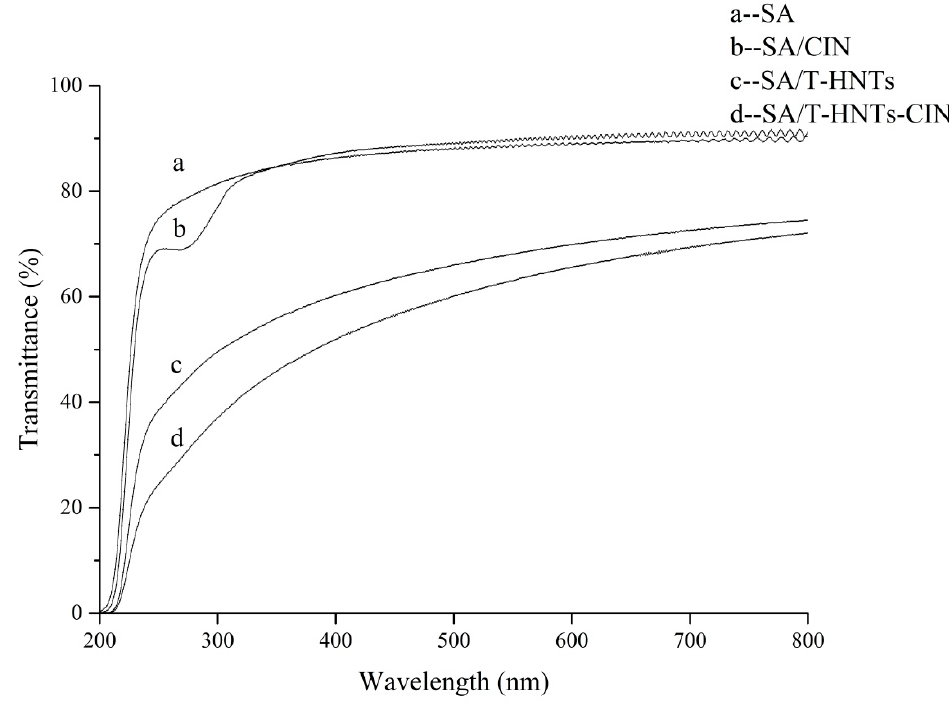
Figure 3. Light transmittance of the nanocomposite film: ( a ) SA film, ( b ) SA/CIN film, ( c ) film, and ( d ) SA/T-HNTs-CIN SA/T-HNTs film, and ( d ) SA/T-HNTs-CIN film.